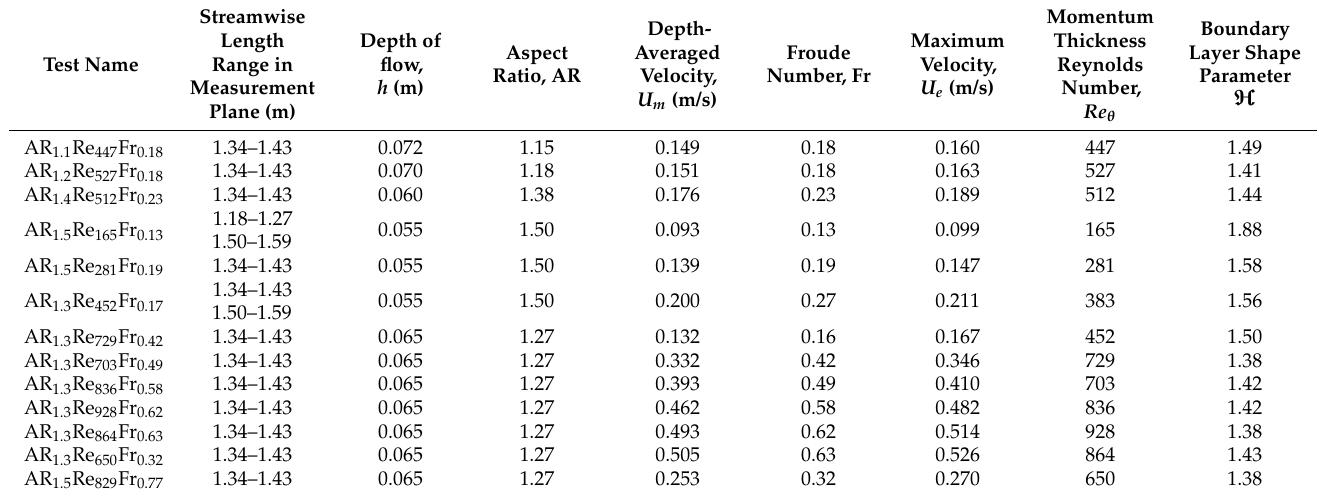
Table 1. Summary of test conditions and relevant boundary layer parameters.